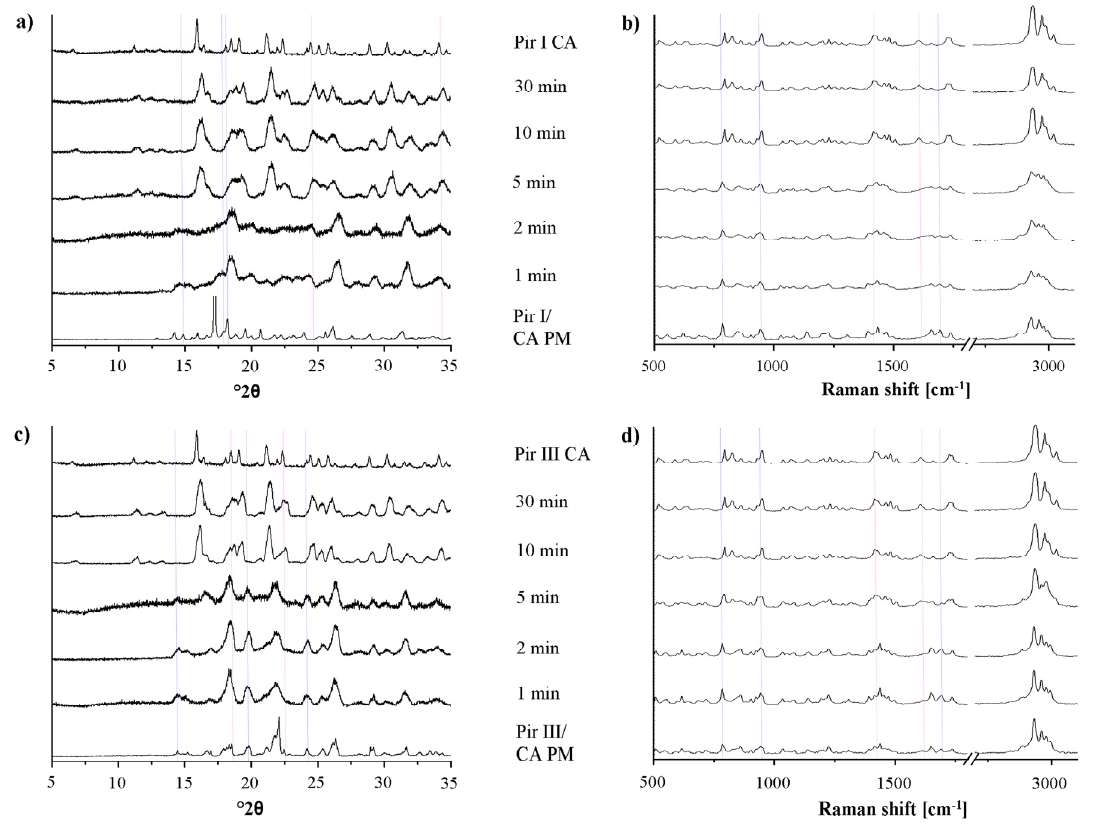
Figure 6. ( a ) XRPD patterns of the physical mixture of piracetam form I and citric acid (Pir I/CA PM), dry-ground for predefined time periods. The piracetam form I-citric acid cocrystal (Pir I CA) reference pattern is included. ( b )Raman spectra of the physical mixture of piracetam form I and citric acid (Pir I/CA PM), dry-ground for predefined time periods. The piracetam form I-citric acid cocrystal (Pir I CA) reference spectrum is included. ( c ) XRPD patterns of the physical mixture of piracetam form III and citric acid (Pir III/CA PM), dry-ground for predefined time periods. The piracetam form III-citric acid cocrystal (Pir III CA) reference pattern is included. ( d ) Raman spectra of the physical mixture of piracetam form III and citric acid (Pir III/CA PM), dry-ground for predefined time periods. The piracetam form III-citric acid cocrystal (Pir III CA) reference spectrum is